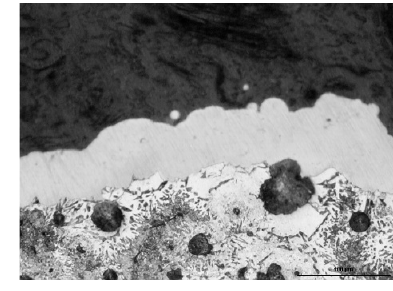
Figure 64: Austempered DCI (R = 0.1,  K = 15 MPa √ m).